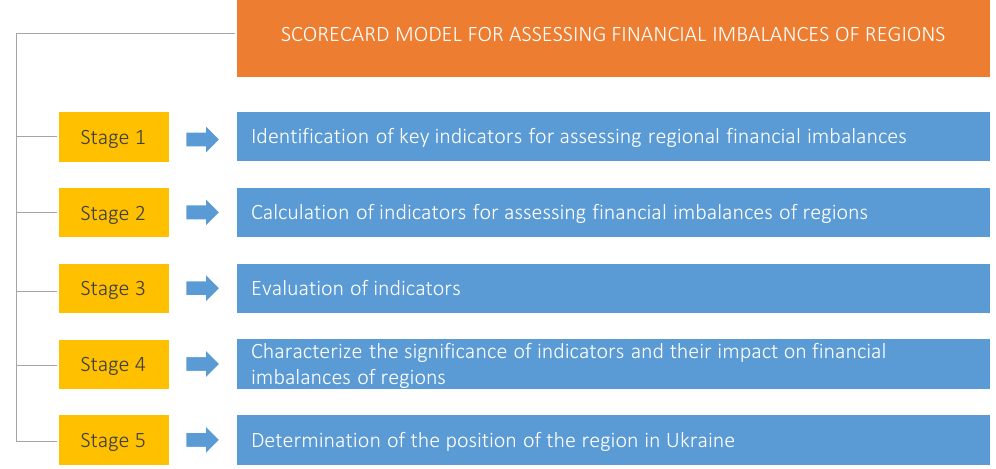
Figure 2. Scorecard model for assessing financial imbalances of